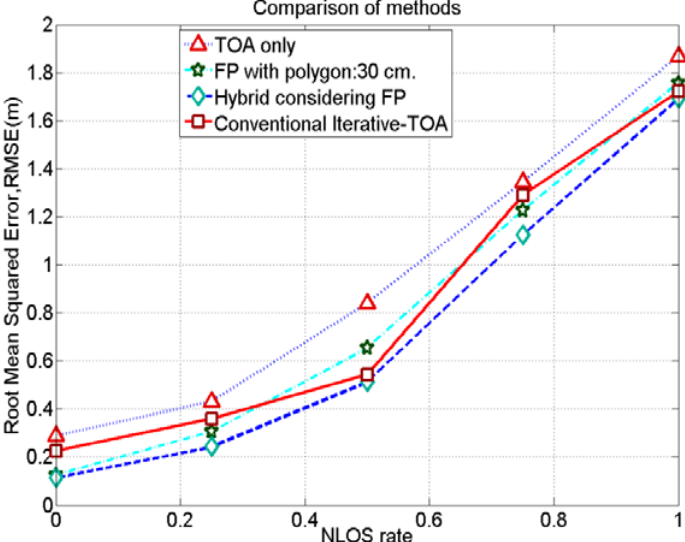
Figure 11. Comparison on positioning accuracies for TOA only, FP only, conventional iterative TOA and hybrid methods in NLOS